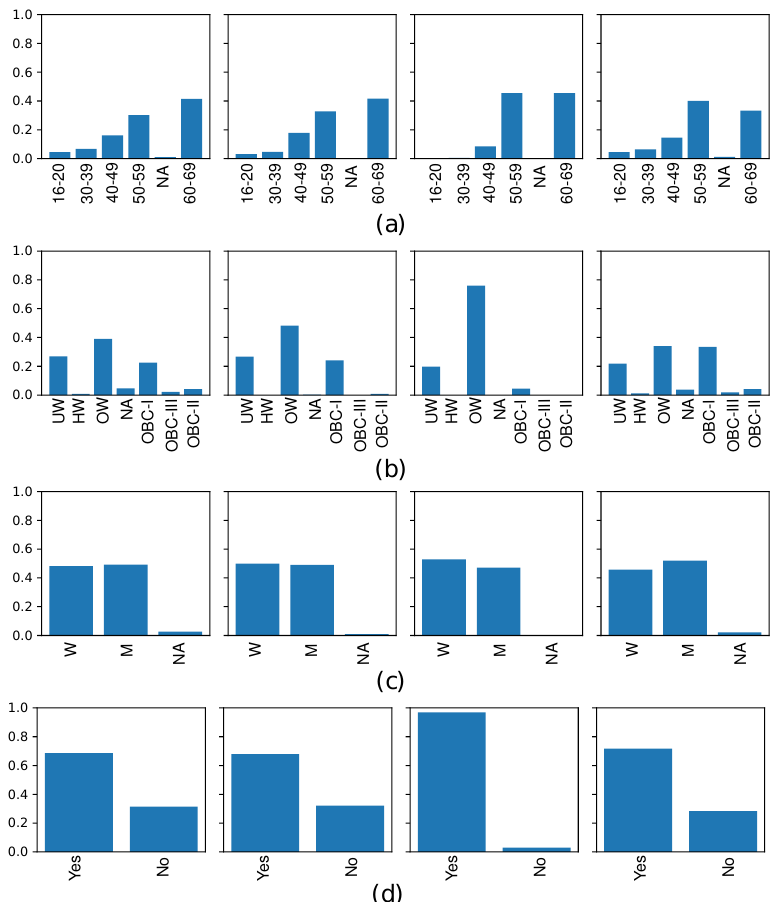
Figure 3. Estimations of the PMFs associated with: ( a ) age; ( b ) BMI; ( c ) sex; and ( d ) high cholesterol. Estimated PMF obtained using real data (first column); SMOTEN (second column); TVAE (third column); and CTGAN (fourth